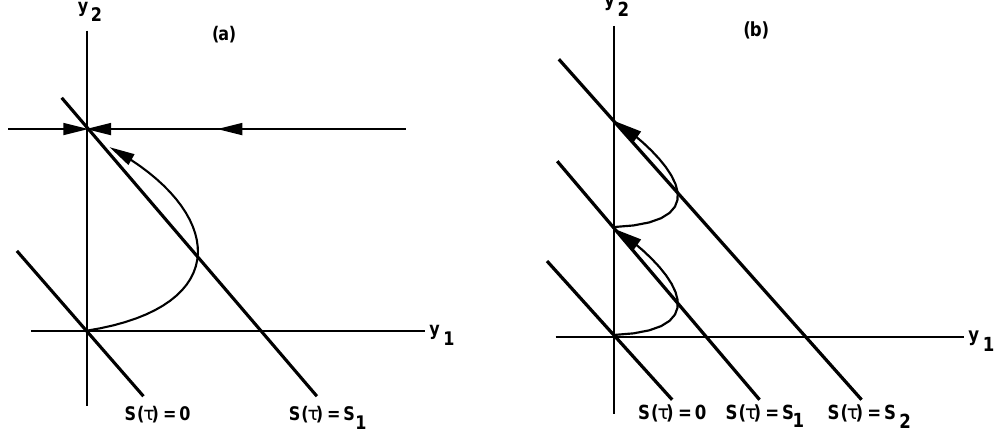
Figure 5. The response to single ( a ) and multiple ( b ) steps in the signal for the model adapting system described by Equation ( 3) when f is a linear